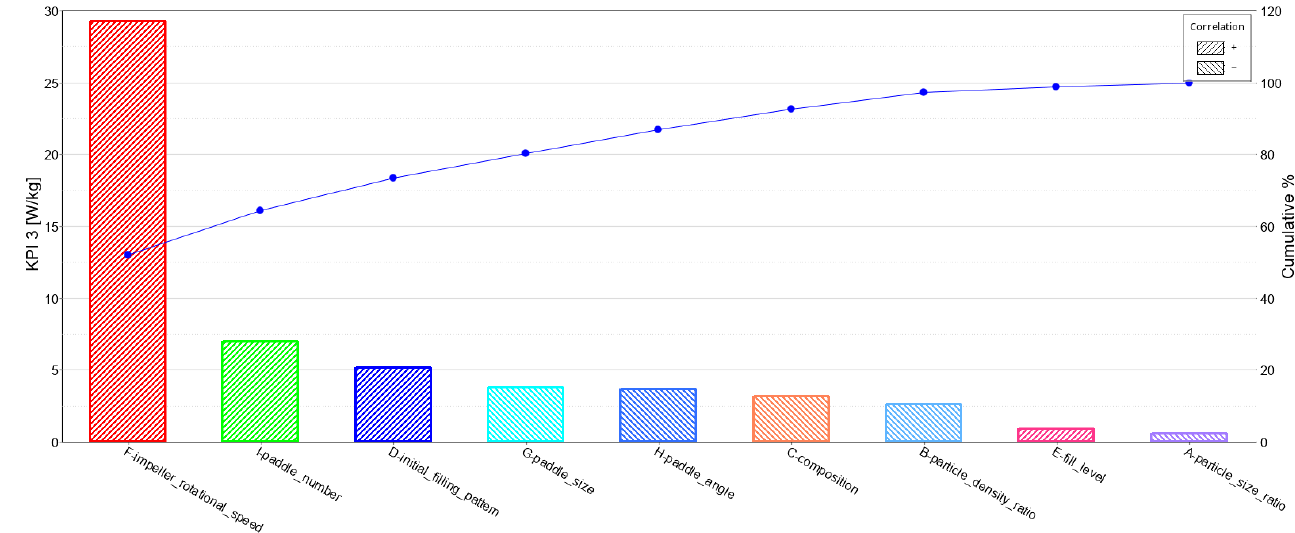
Figure 10. Pareto plot for KPI 3 average mixing power.